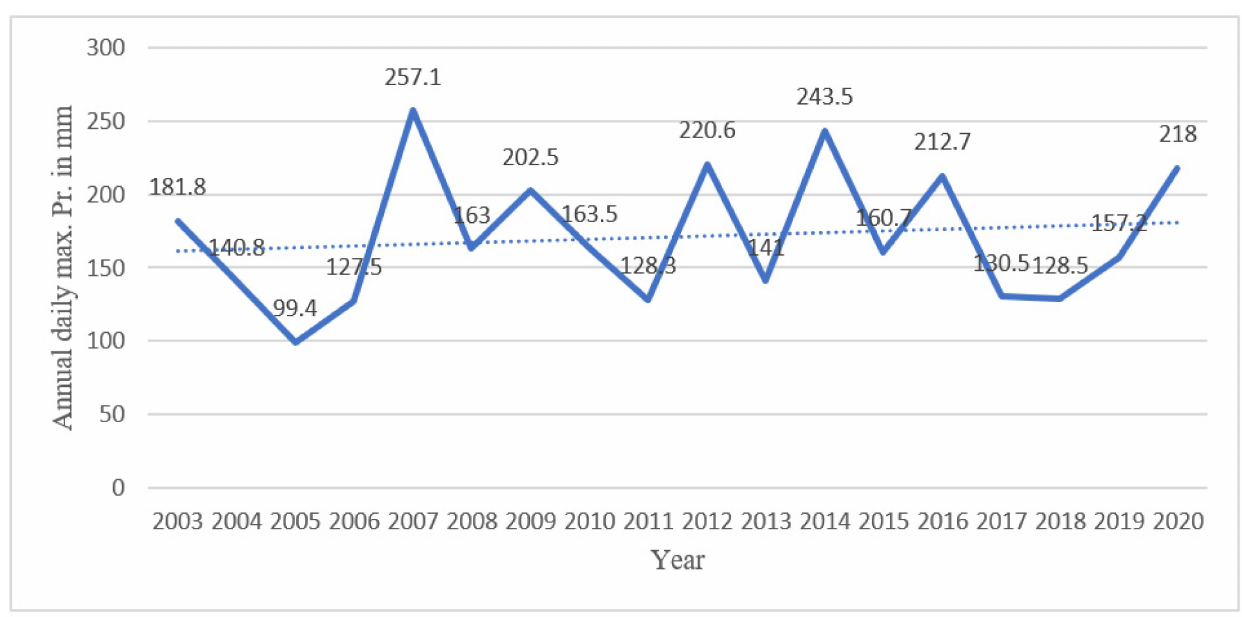
Figure A12. Observed annual daily maximum precipitation of